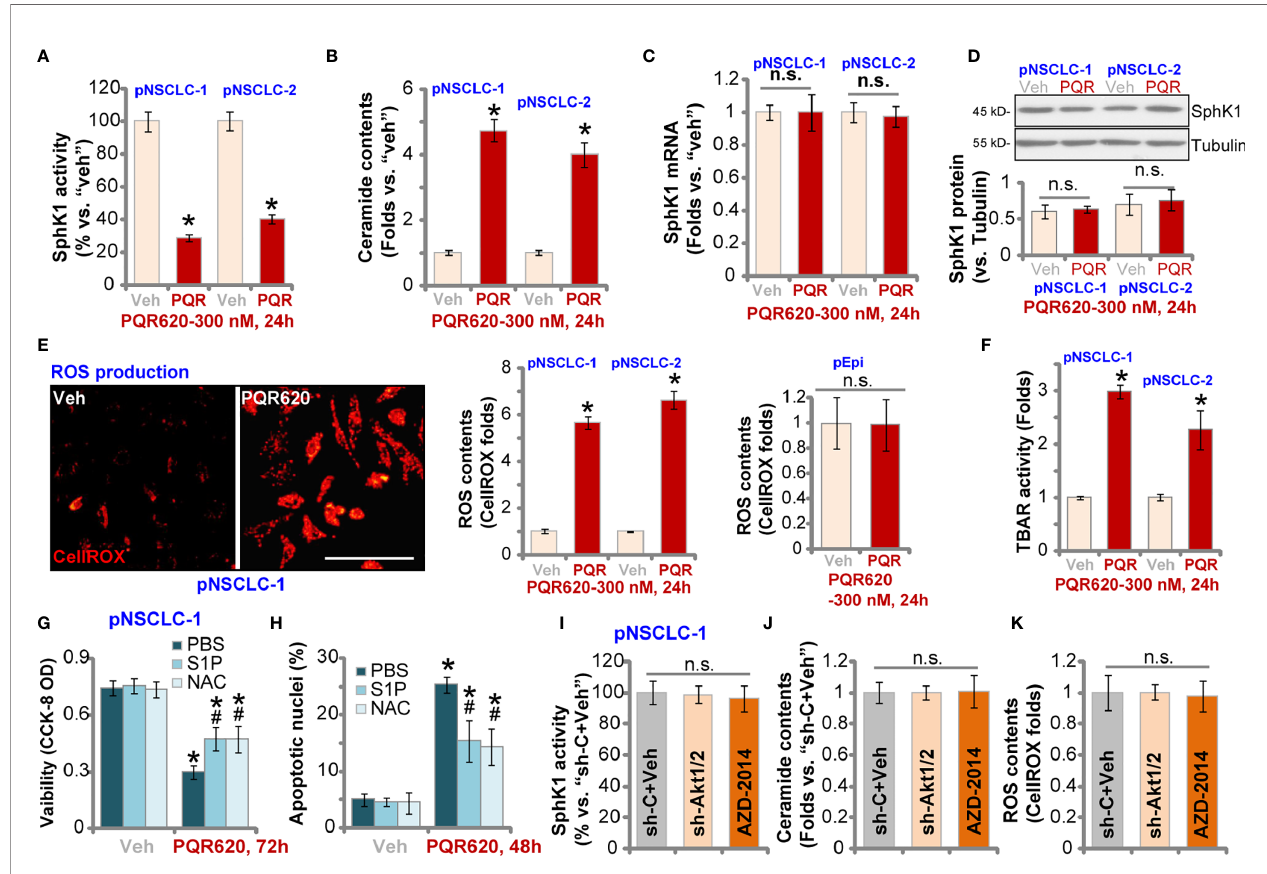
FIGURE 5 | PQR620 inhibits SphK1 activity and induces oxidative injury in NSCLC cells. Primary NSCLC cells, pNSCLC-1/-2, or lung epithelial cells ( “ pEpi ” ), were treated with PQR620 (300 nM) or the vehicle control ( “ Veh ” ).Cells were further cultured for indicated time periods, and SphK1 activity (A) , ceramide contents (B) , SphK1 mRNA (C) and protein (D) expression, as well as cellular ROS contents (by testing CellROX intensity, E ) and lipid peroxidation (by testing TBAR activity, F ) were tested using the described methods, with results normalized. pNSCLC-1 cells were treated with PQR620 (300 nM) fi rst, then with or without sphingosine-1 phosphate (S1P, 1 m M) or NAC (400 m M). Cells were further cultured, with cell viability and apoptosis tested by CCK-8 (G) and apoptotic nuclei staining (H) assays, respectively. Relative SphK1 activity (I) , ceramide levels (J) and ROS contents (K) in pNSCLC-1 cells with Akt1/2 shRNA (sh-Akt1/2) are shown here with scramble control shRNA (sh-C) or AZD-2014 treatment (300 nM, 24 h). Data were presented as mean ± standard deviation (SD, n=5). * p < 0.05 vs. “ Veh ” cells. # p < 0.05 vs. PQR620 only treatment (G , H) . “ n.s. ” stands for non-statistical difference (D , E , I – K) . Experiments were repeated fi ve times with similar results obtained. Scale Bar= 100 µm (E)